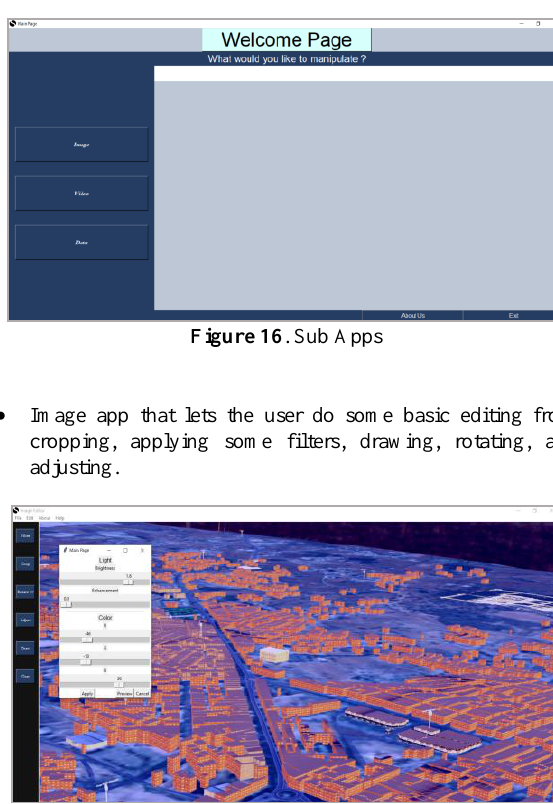
Figure 17 . Image App interface • Data App: for visualizing Data frames in the form of the tree view.